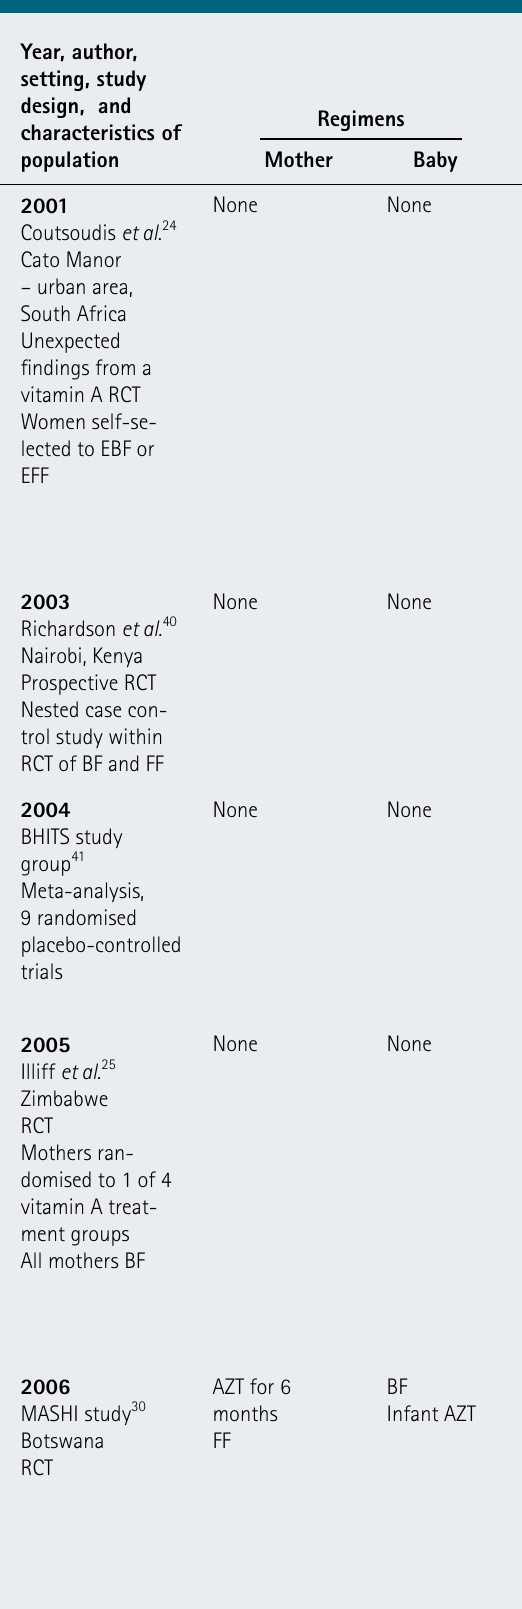
TABLE I. KEY STUDIES THAT HAVE CONTRIBUTED TO THE BODY OF KNOWLEDGE ON HIV AND INFANT FEEDING